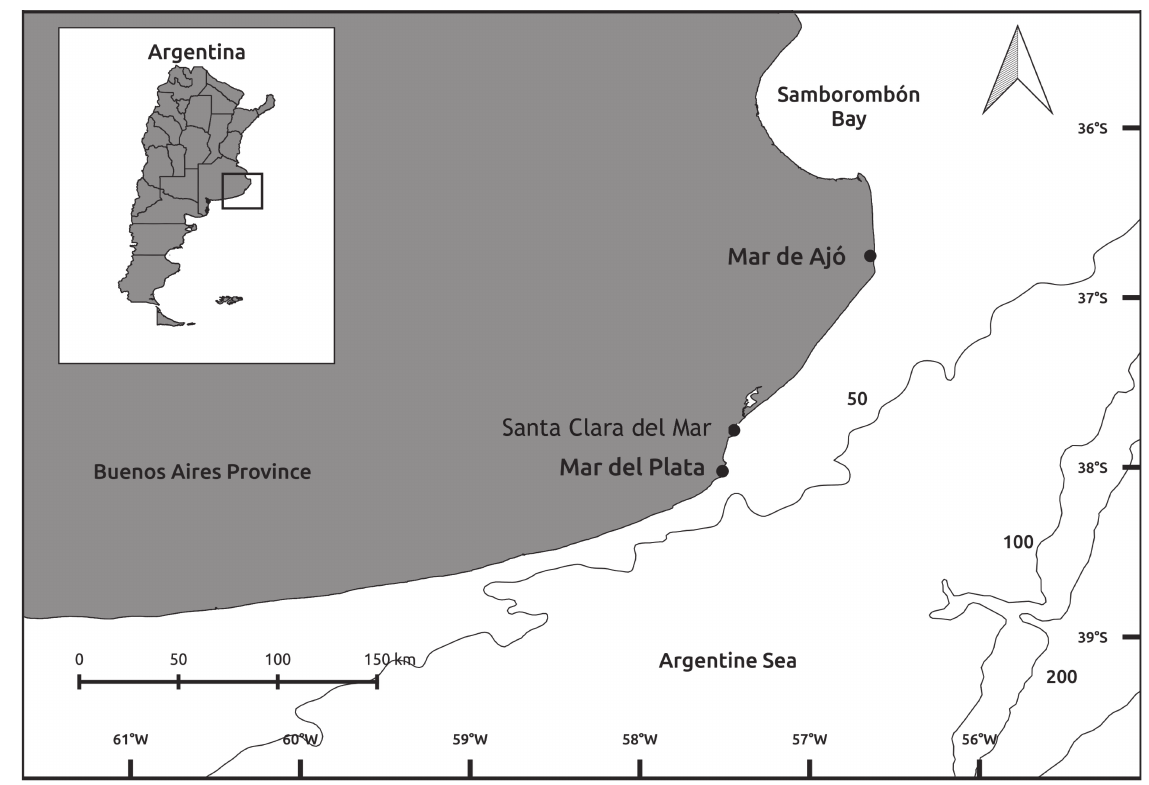
Fig. 1 . Map of the study area. Continuous lines are isobaths (in meters). The inset shows the location of the study area in